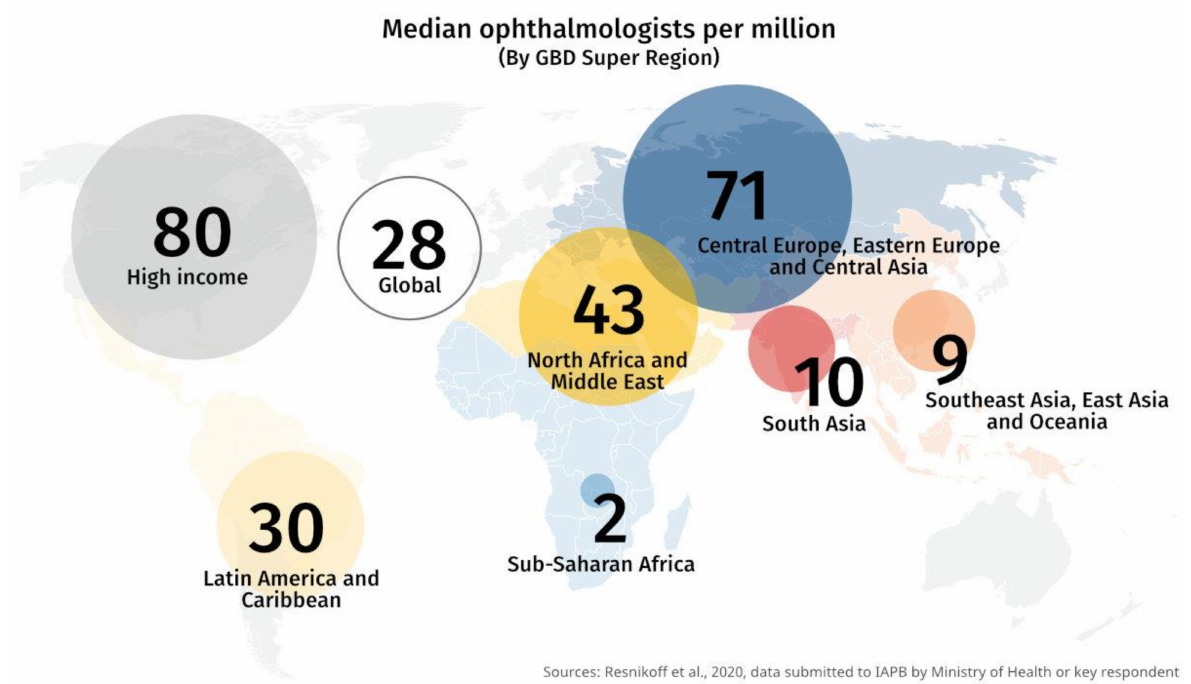
Figure 1. Highlighting the shortage of ophthalmologists in SSA compared to other regions